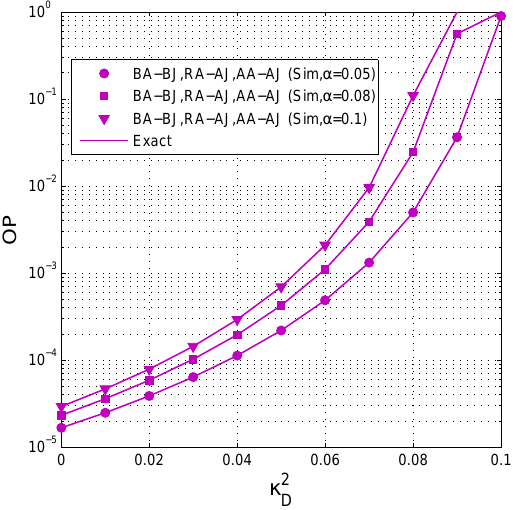
Figure 4. OP as a function of M when ∆ = 5 (dB), C K = 3 , α = 0 . 1 and µ 2